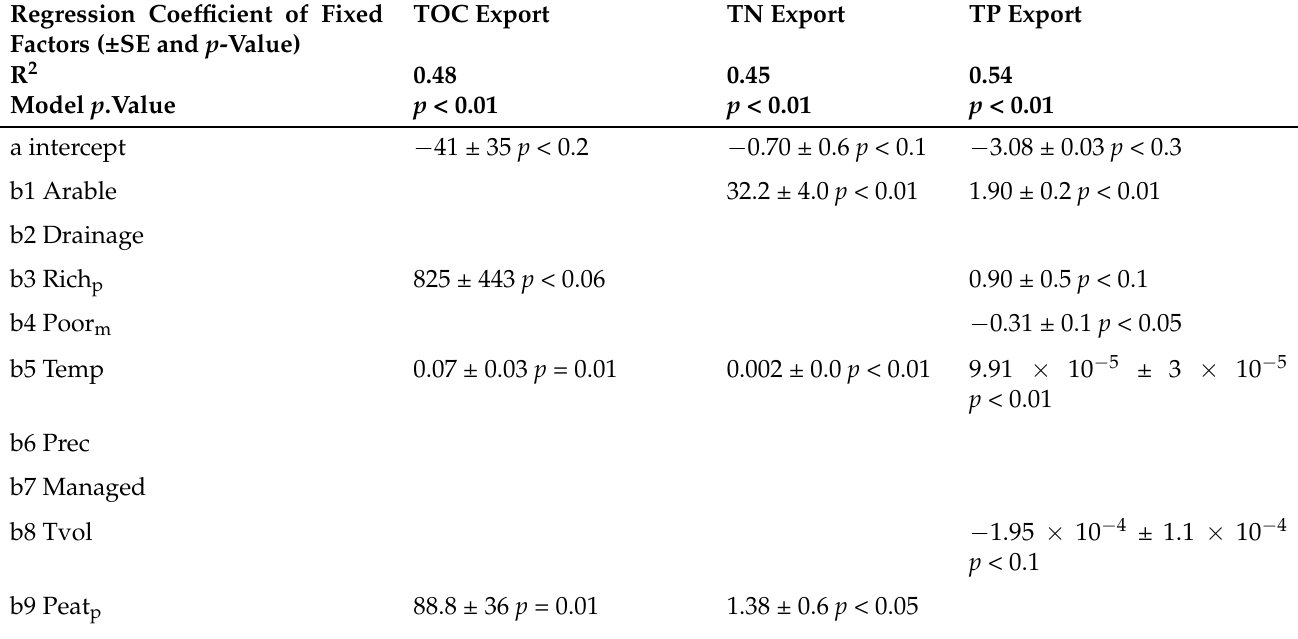
Table 2. Parameter estimates of fixed factors of the final models for